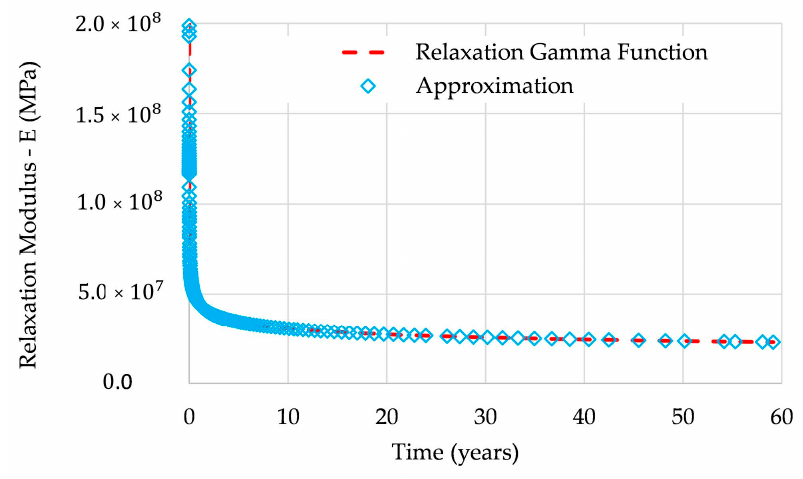
Figure 1. Exponential-power-law (EPL) Γ -function and approximation are given by (36) .